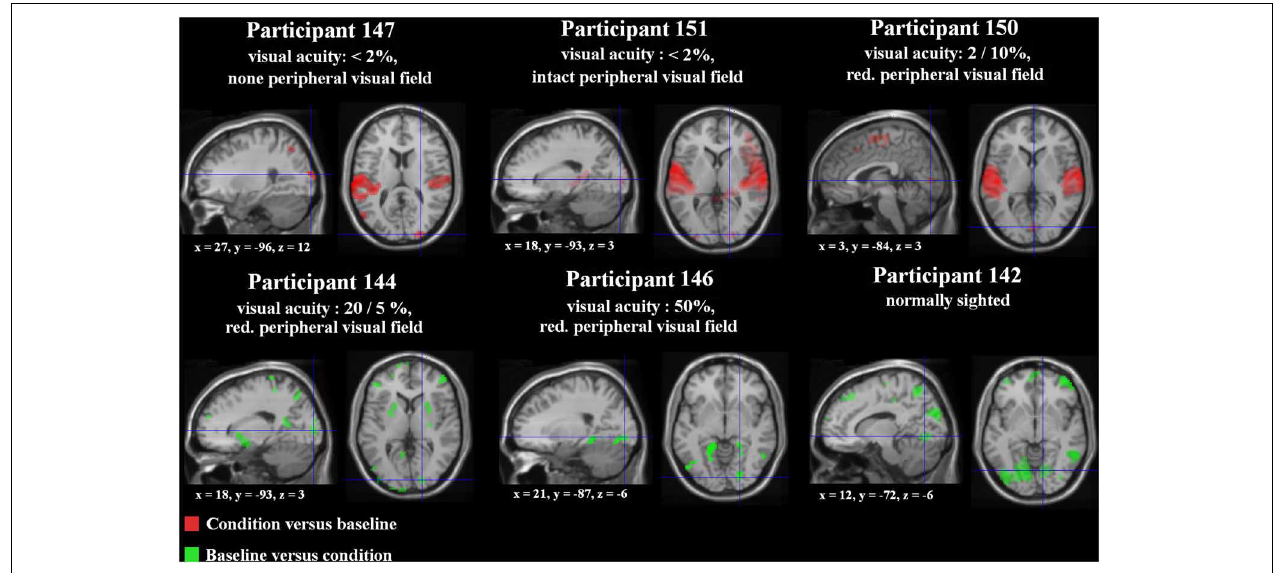
FIGURE 2 | Special location of the right-hemispheric visual cluster (fixation cross) overlaid on lateral and medial brain structures in each subject (T1 MNI template) based upon the SPM T -contrast for forward ultra-fast speech vs. baseline